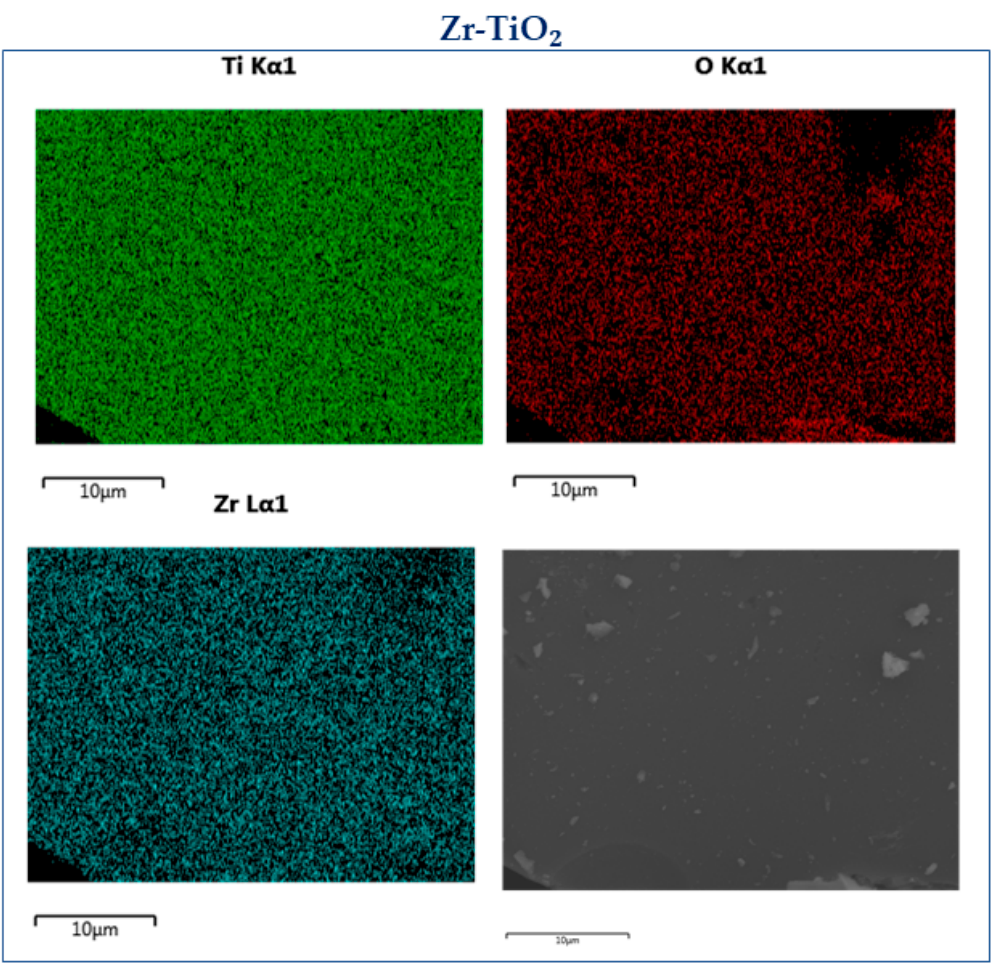
Figure 4. EDX maps over the Zr-doped sample.